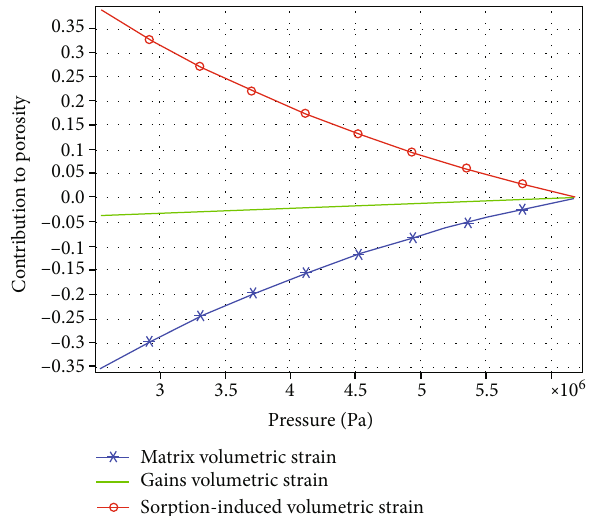
Figure 9: E ff ect of adsorption strain and volume strain on porosity.